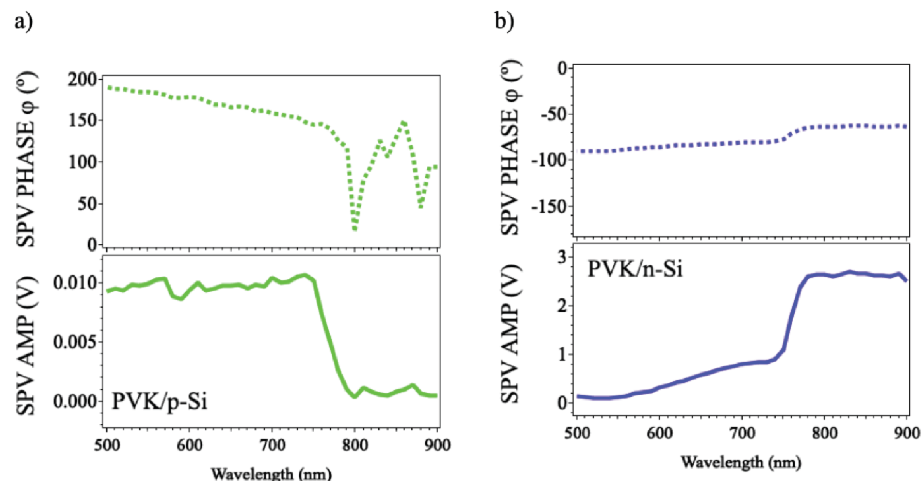
Fig. 4. The SPV results of PVK/p-SI (a) and PVK/n-Si (b) measured by MIS technique. The top graph shows SPV phase, and the bottom graph shows SPV